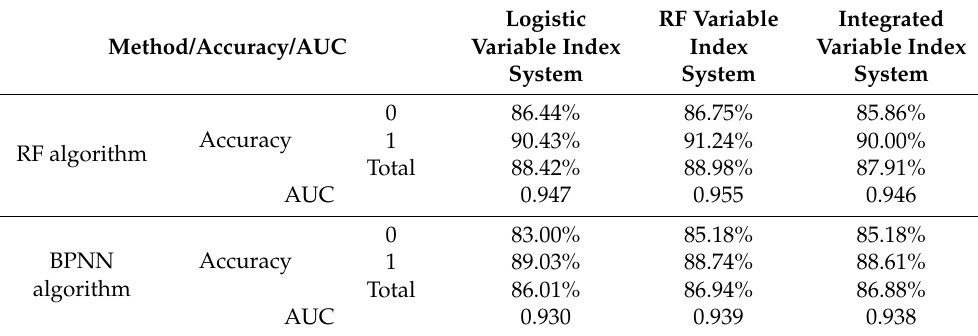
Table 3. Results of the